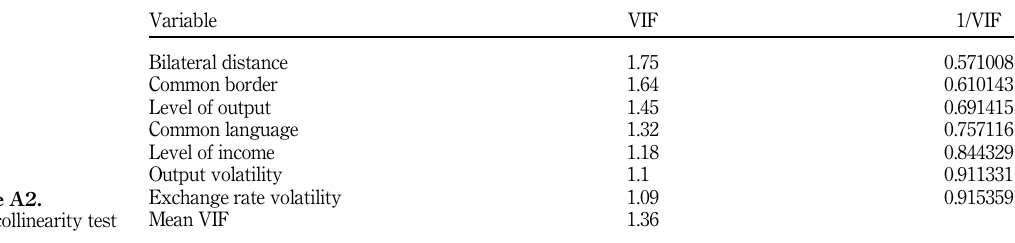
Table A1. Sources of data